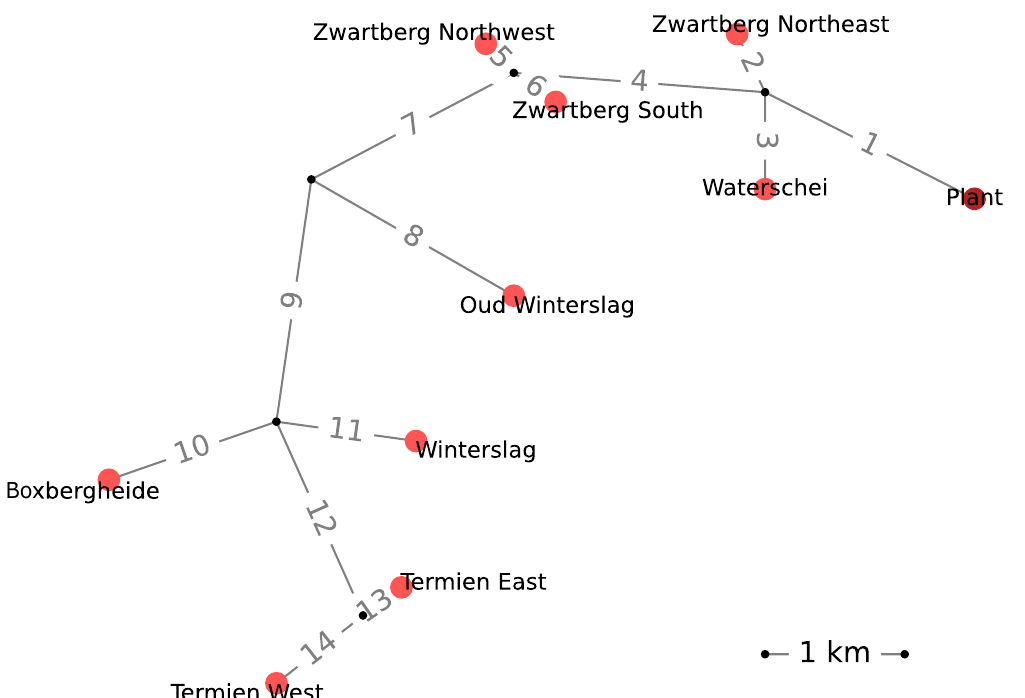
Figure 2. The lay-out of the aggregated GenkNET , indicating the position of the nine neighbourhoods. There is a single heat generation site in the north-east of the network. The network pipes are indicated by the numbered